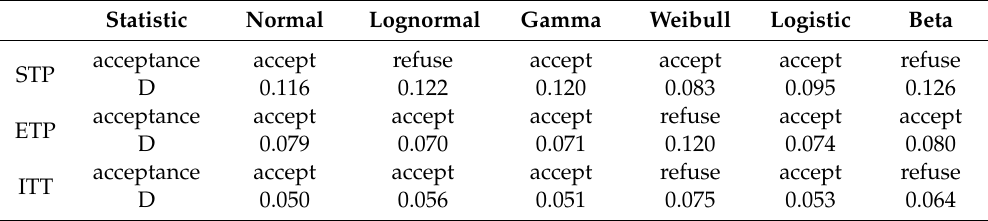
Table 4. K-S test results of random variables with six reference distribution.